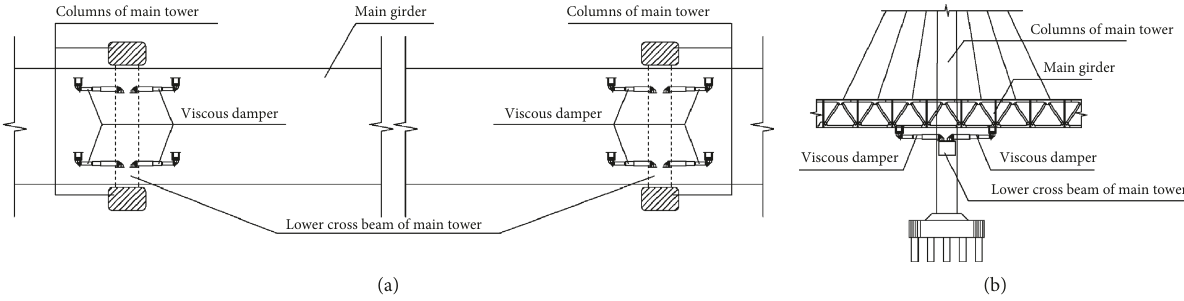
Figure 11: Locations of viscous dampers between the main tower and main girder. (a) Planar graph. (b) Elevation graph.